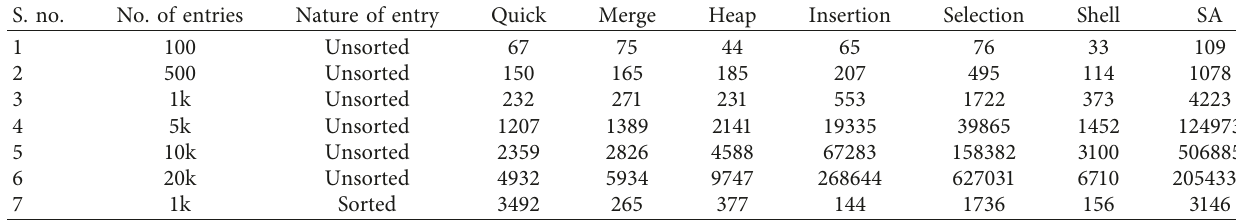
Table 1: Comparison of execution time in microseconds.